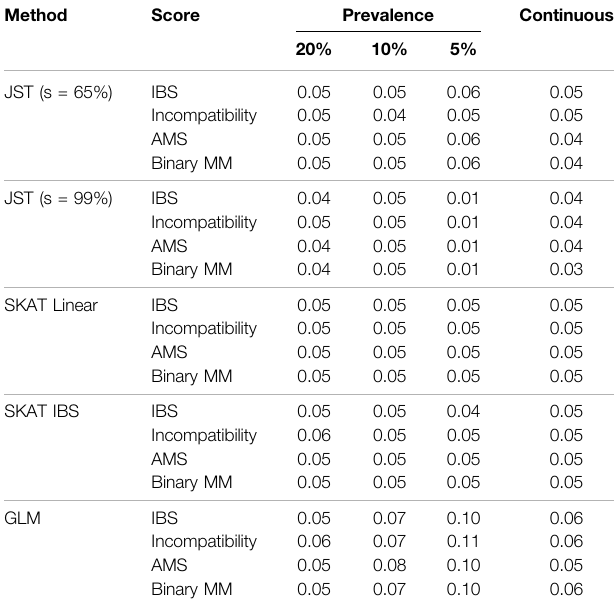
TABLE 1 | Results of Type I Error simulations for the gene NAT2 with 500 D/R pairs. Method refers to one of the four multi-marker methods used for testing. Score refers to the gene-based score that was fi t as part of the modeling. The columns Prevalence 20, 10, and 5% give results for binary outcome Y, and the continuous column gives results for continuous outcome Y . JST stands for Joint Score Test, with s value (percent of variance explained by the PCs) indicatedinparentheses.Resultsfor s valuebetween70and95%weresimilar to those for s (cid:2) 65%. SKAT stands for Sequence Kernel Association Test. SKAT (Linear) refers to using SKAT with an unweighted linear kernel. SKAT (IBS) refers to fi tting SKAT with an unweighted IBS kernel. GLM stands for Generalized Linear